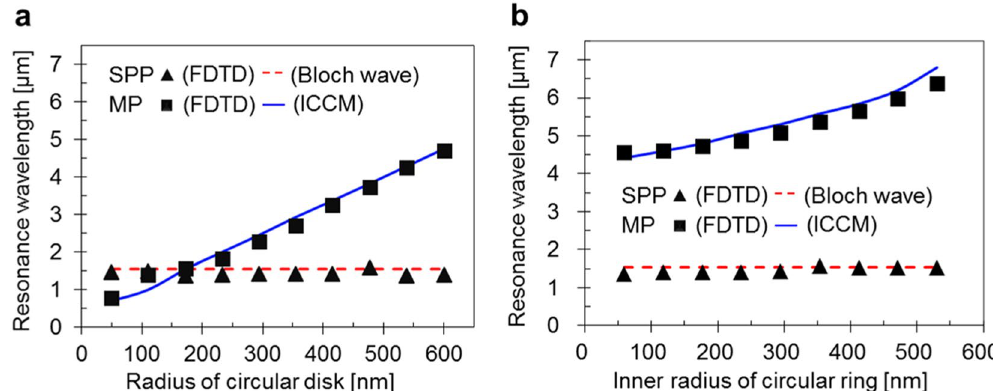
Figure 2. Simulation results and MP and SPP resonance wavelength predictions. Resonance wavelengths of the SPPs and MPs excited by ( a ) the disk array for various disk radii and ( b ) the ring array for various inner radii of the rings. In both the graphs, the Bloch wave and ICCM results (represented by the dashed and solid lines, respectively) correspond closely to the SPP and MP FDTD results (represented by ▲ and ■ ,